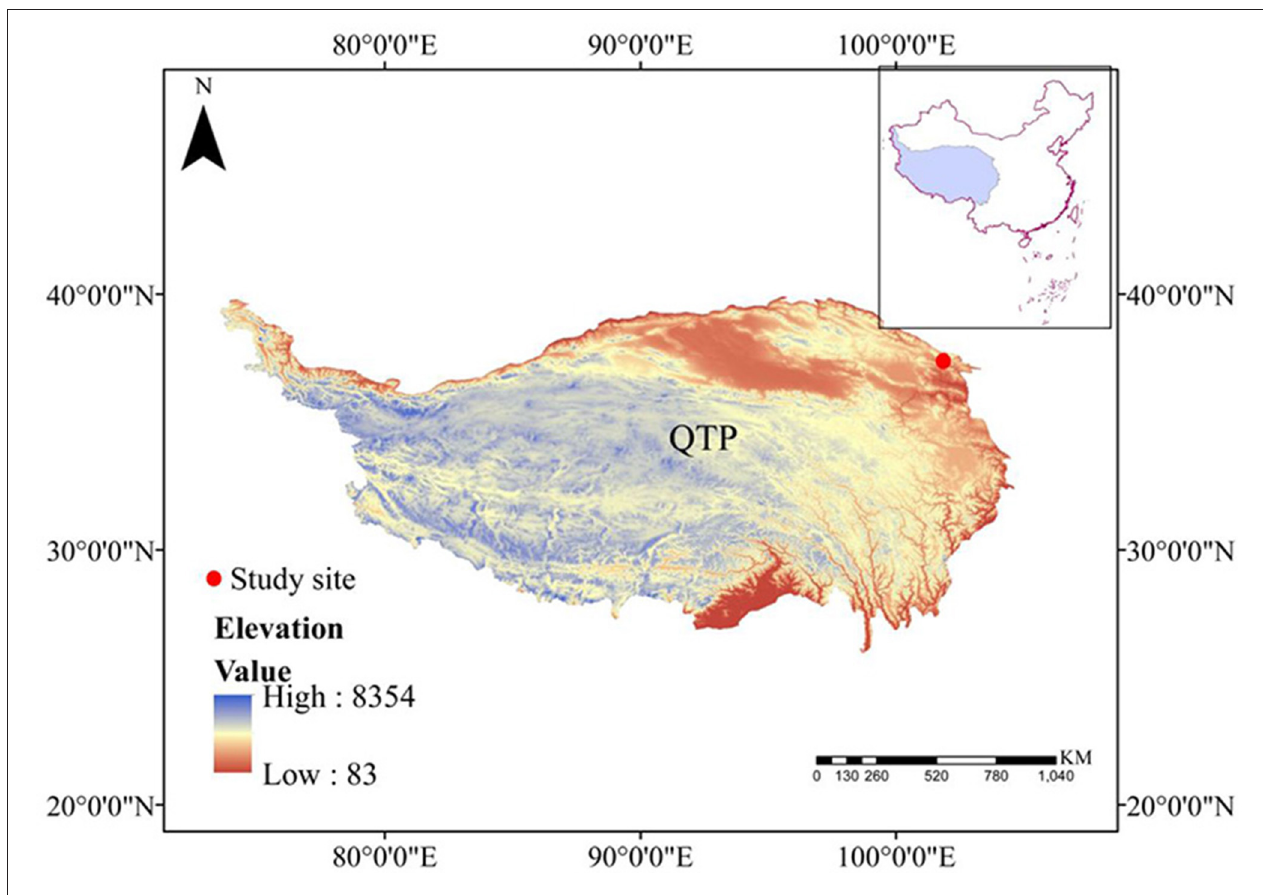
FIGURE 1 | The location of the study area.